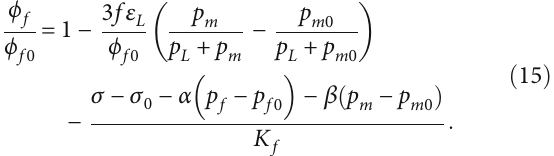
Figure 6: Matching results of the dynamic elastic modulus model with laboratory test data under constant external stress